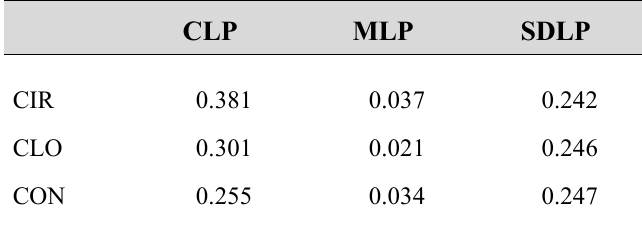
Table 5 Averages for the different